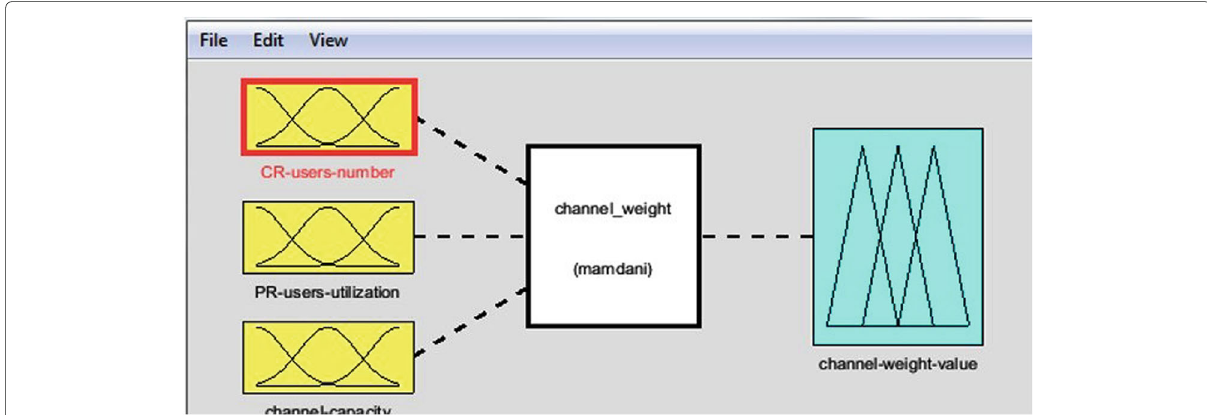
Fig. 4 Fuzzy system for the proposed model. The inference techniques and the fuzzy system used for the proposed ILFCS strategy are